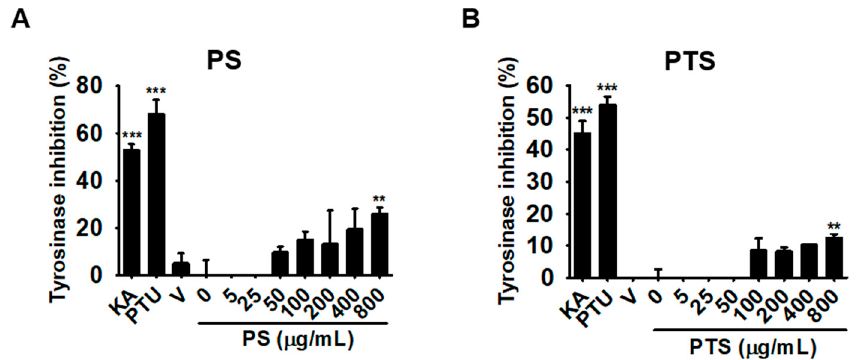
Figure 3. PS and PTS do not downregulate mushroom tyrosinase activity in vitro . The inhibitory activity of PS ( A ) and PTS ( B ) on mushroom tyrosinase was measured in vitro . PS or PTS (0–800 µ g / mL), kojic acid (KA, 25 μ M) and PTU (250 nM) were loaded onto a 96 ‐ well microplate. After incubation with mushroom tyrosinase at 37 °C for 30 min, dopaquinone level was measured by spectrophotometry at 490 nm. The percentage values in each experiment are expressed relative to those of untreated control. Data are reported as the mean ± SEM of three independent experiments performed ( n = 3). ** p < 0.01 and *** p < 0.001 vs. untreated group. V, vehicle (0.01% DMSO).